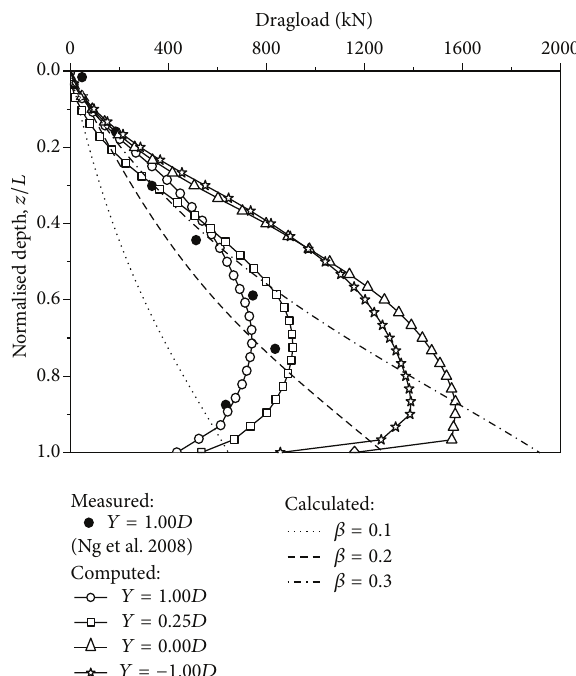
Figure 4: Measured and computed dragload distribution due to a surcharge